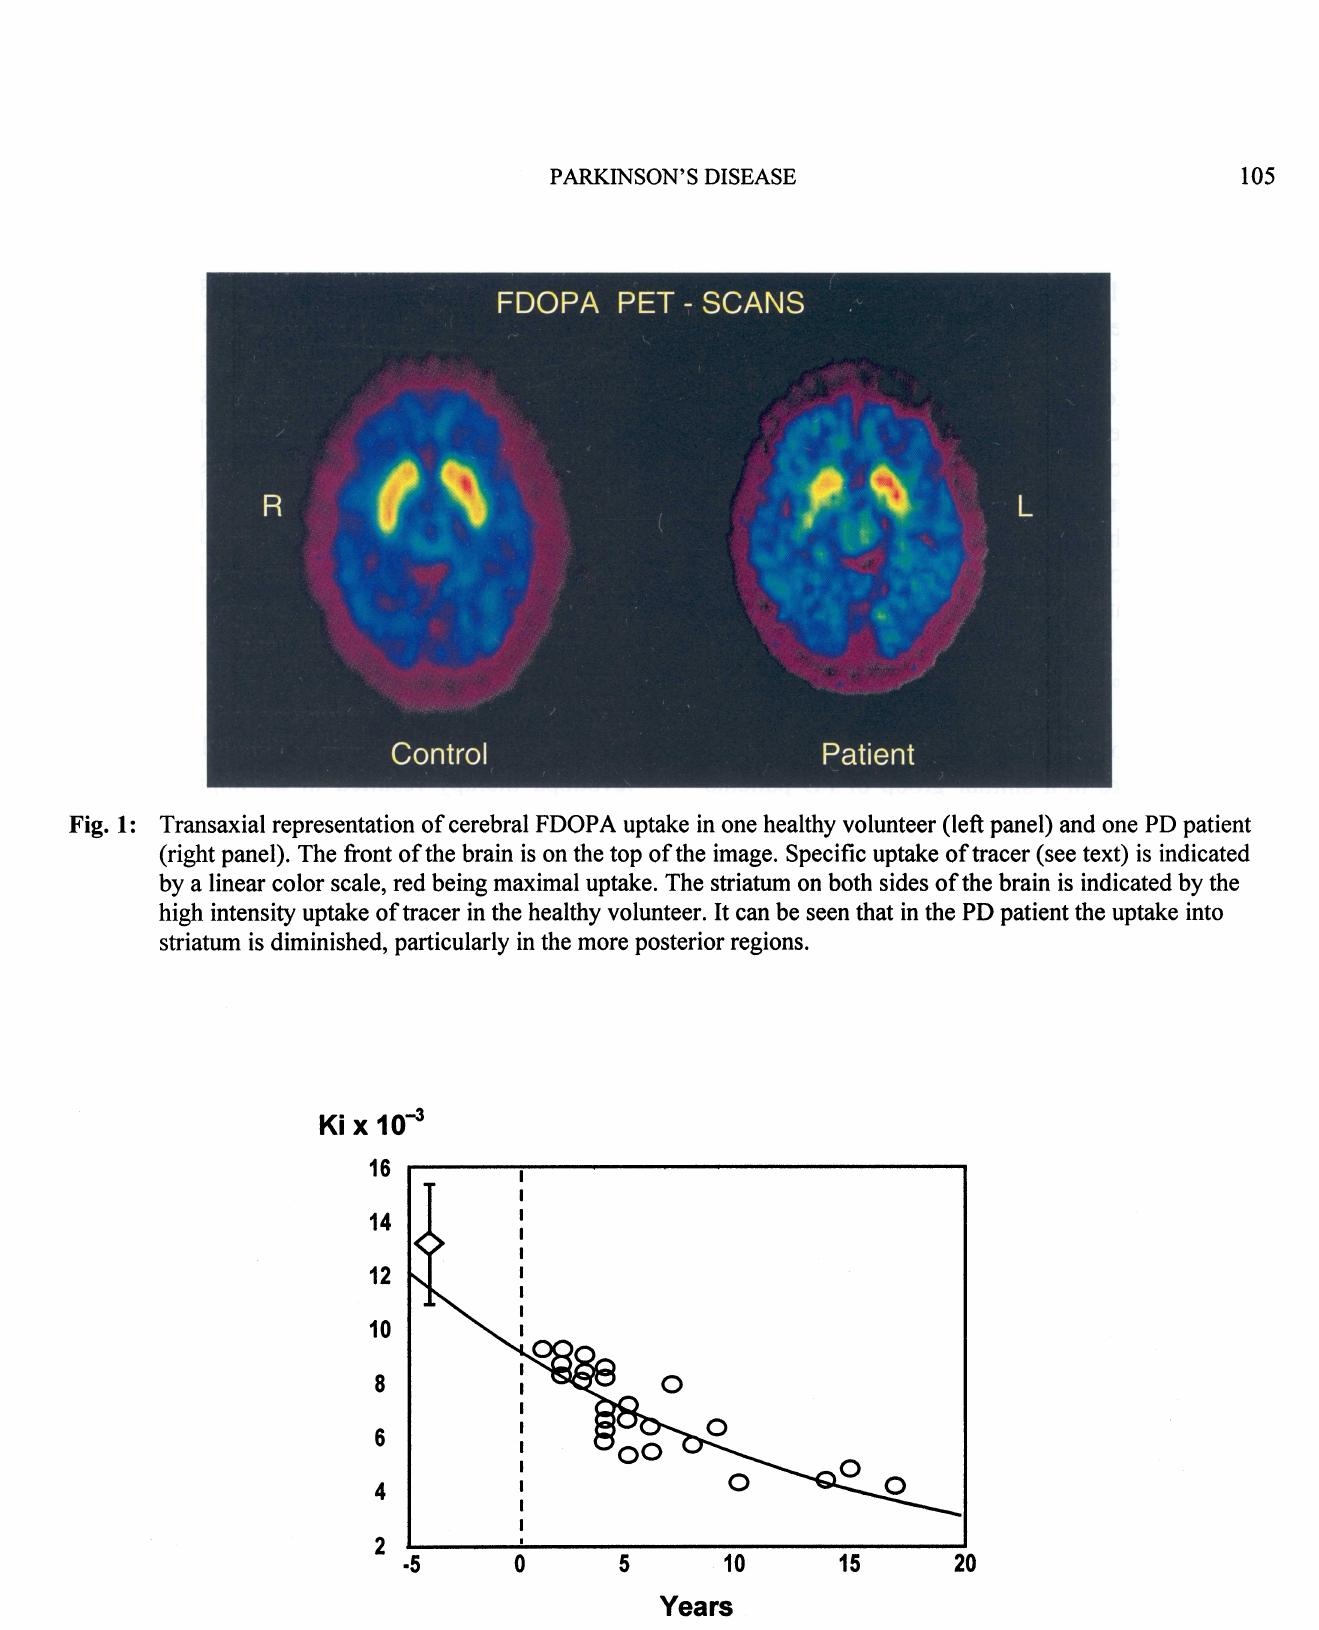
Correlation between specific FDOPA uptake (expressed as Ki see text) in putamen and disease duration in patients with PD. Values are compared to healthy age-matched control mean and two SD. Open circles are PD patients and the open diamond is the mean of the